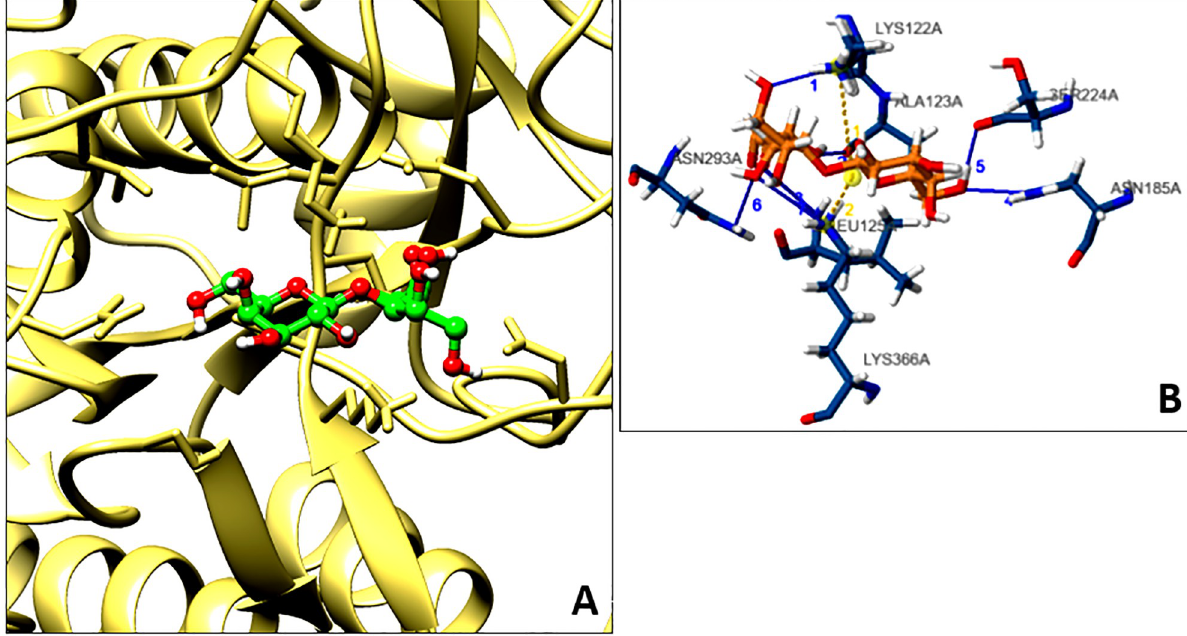
Fig 6. Three dimensional view of lactose in the binding pocket of CAASPR-HM49 subtilisin like protease (A). Interaction profile of lactose with various residues of this protease (B). Total seven hydrogen bonding interactions and two salt bridges exist between lactose and CAASPR-HM49 subtilisin like protease in docked state (blue solid lines represent hydrogen bonds and golden dotted lines depict salt bridges).